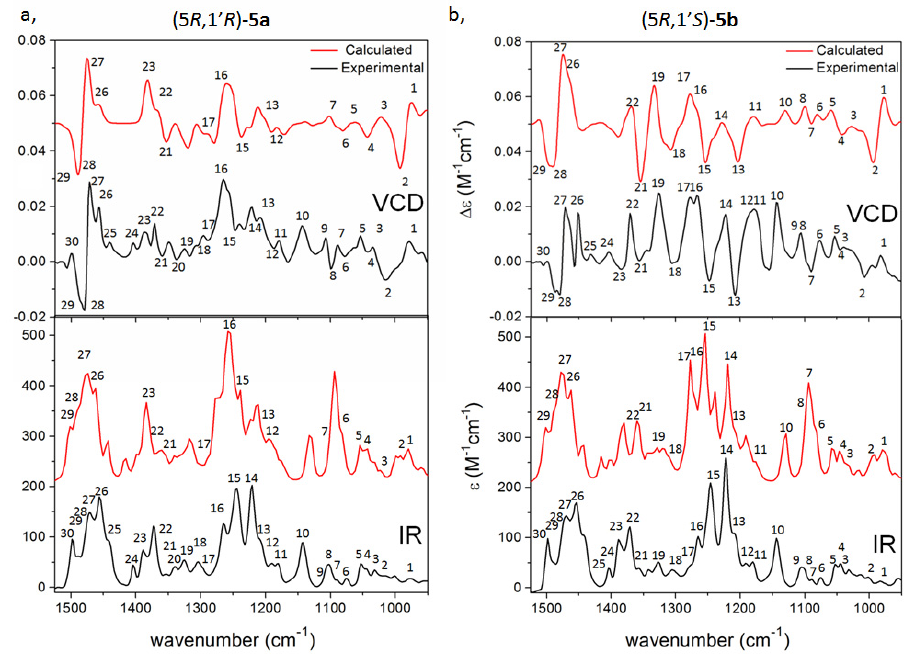
Figure 2. Experimental VCD (upper black, CDCl 3 ) and IR spectra (lower black, CDCl 3 ) of ( a ) (5 R ,1 ′ R ) ‐ 5a and ( b ) (5 R ,1 ′ S ) ‐ 5b compared with the B3LYP/TZPV PCM/CHCl 3 VCD (upper red) and IR (lower red) spectra.